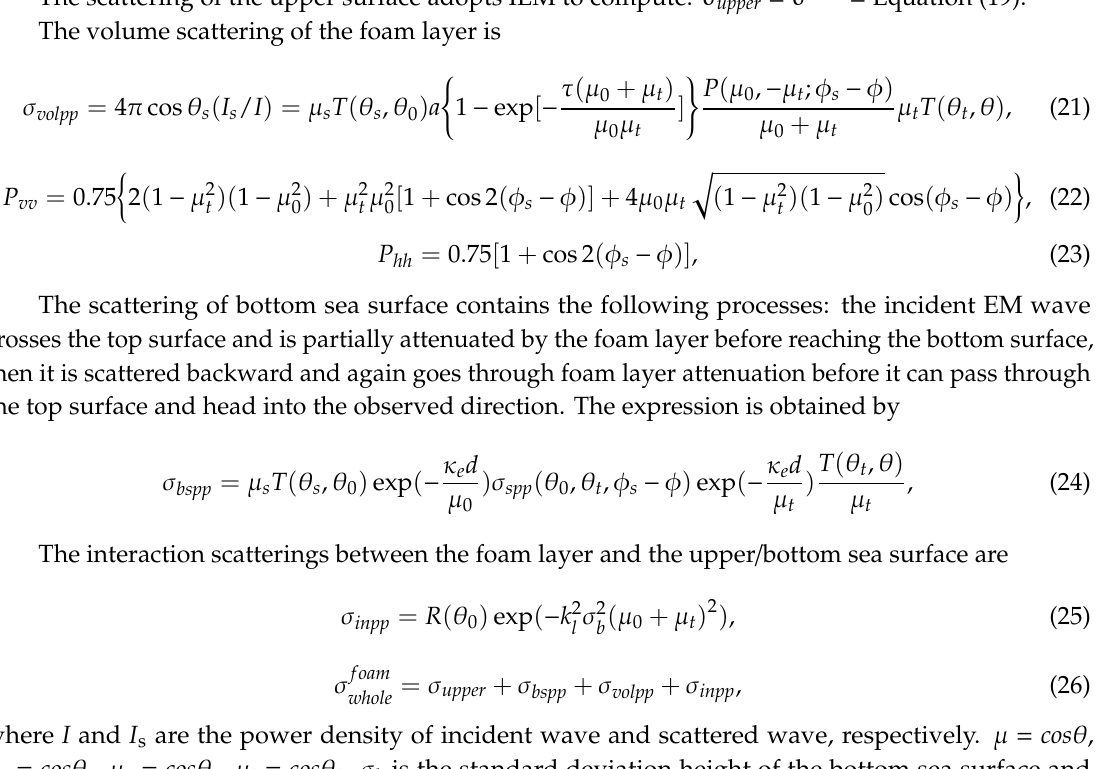
Figure 6. The scattering model of the sea surface covered with the foam layer. (1), (2), (3) and (4) represent the four scattering contributions for Electromagnetic (EM) scattering model.